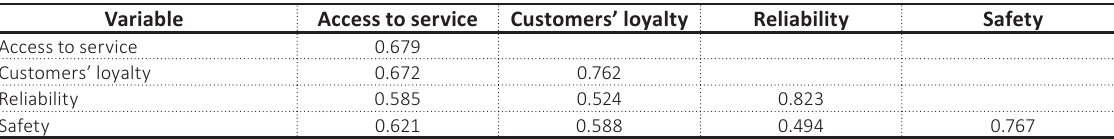
Table 5. Discriminant validity